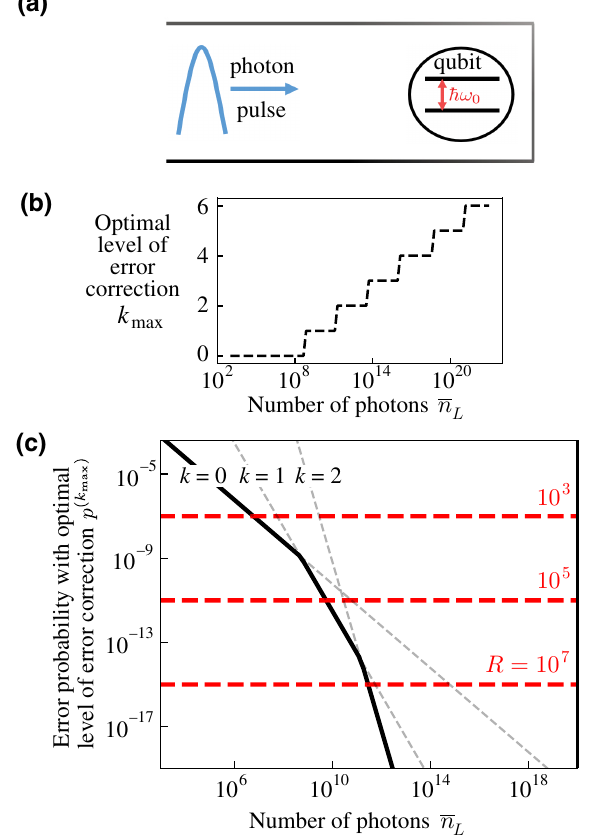
FIG. 5. (a) A qubit-in-waveguide schematic: the photon pulse for gate operations. (b) k max as a function of number of photons per logical gate n L = n tot / R 2 (see text). (c) The lowest possi- ble error per logical gate p ( k max ) as a function of n L = n tot / R 2 , for Shor’s factoring algorithm. The horizontal red dashed lines correspond to the different target ( p err ) values for different R